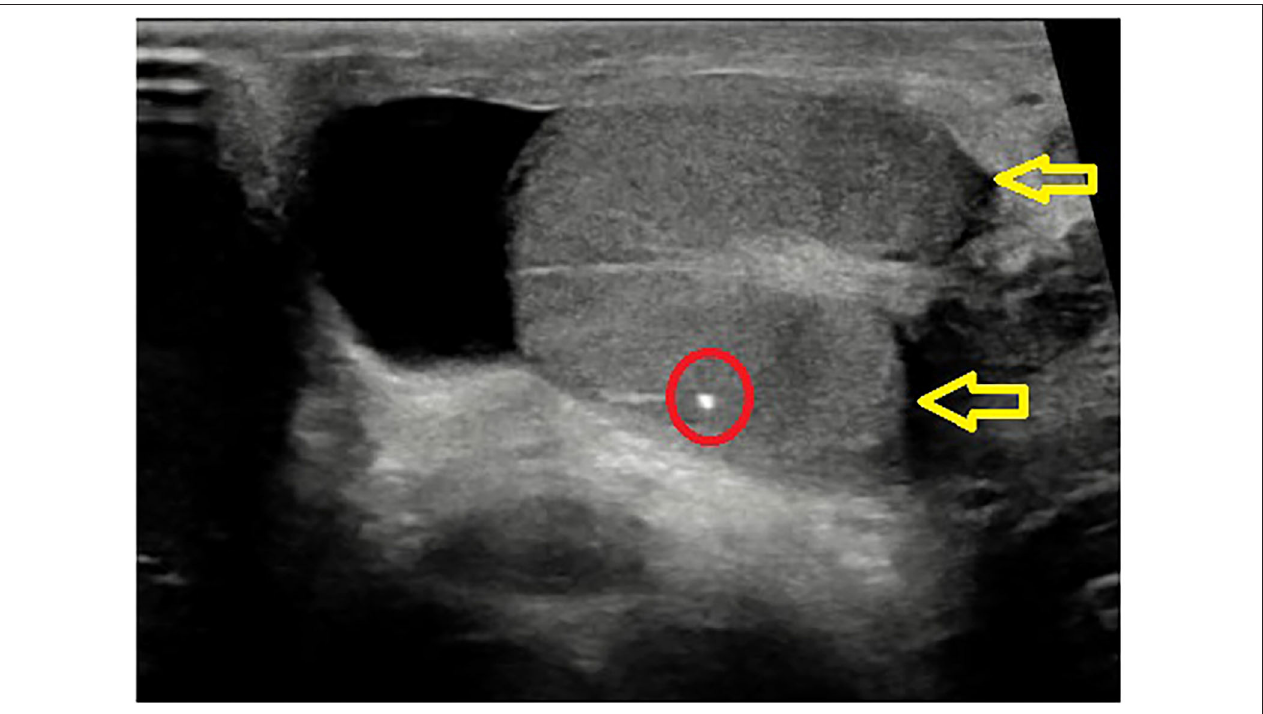
FIGURE 1 | Burned out echographic appearance: scrotal ultrasound showing testicle with microcalcifications and hypoechogenic nodule.